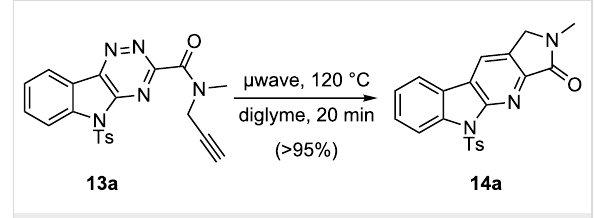
Scheme 4: Microwave-promoted IEDDA reaction of isatin derived triazines.